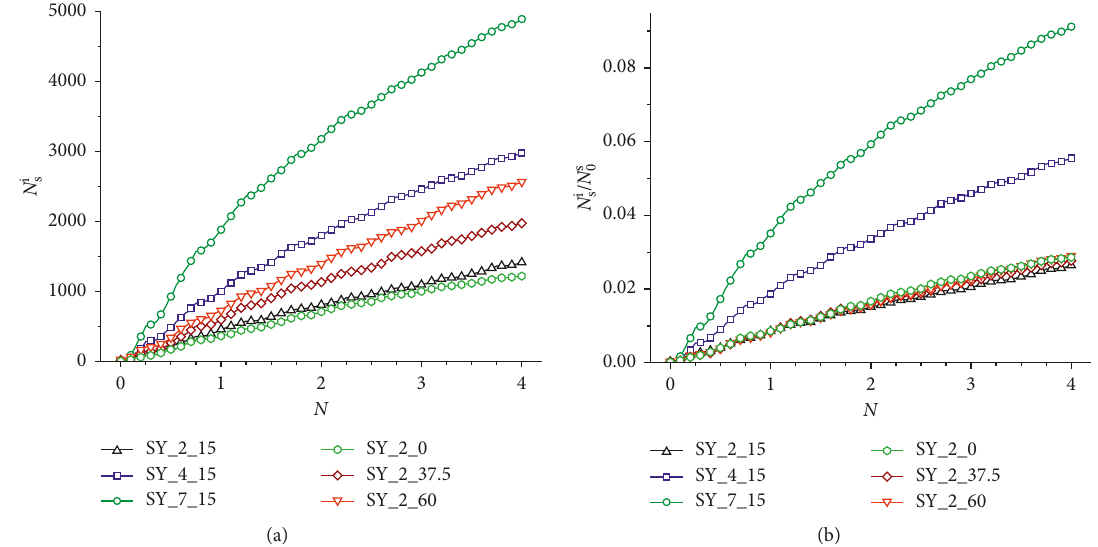
Figure 12: Evolution of the number of independent spheres: (a) absolute; (b) normalized. N i number of spheres; N i